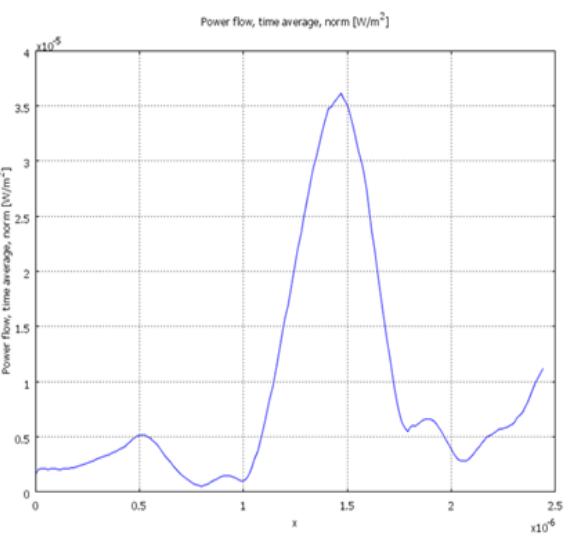
Figure8: Normalized output